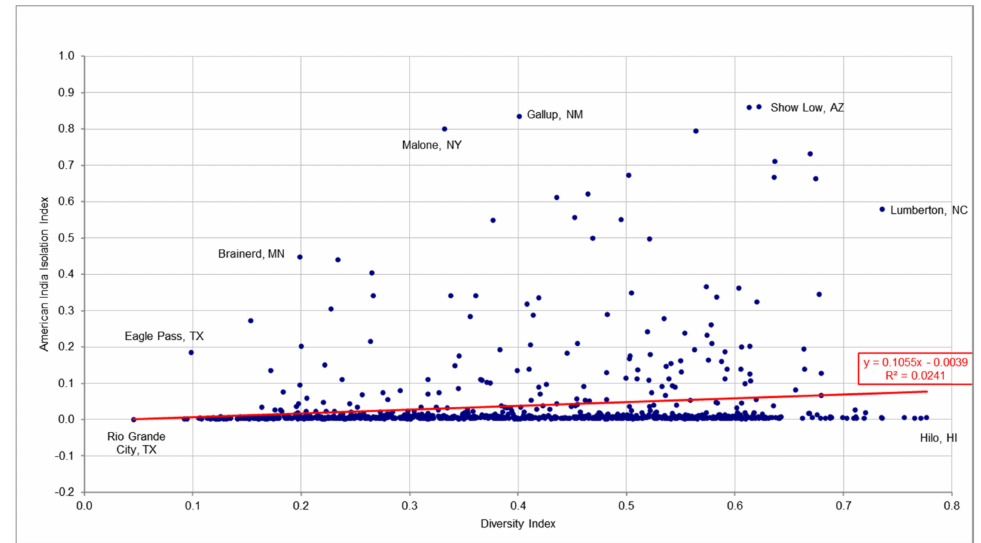
Figure 28. Relationship Between Diversity and Native American Isolation.